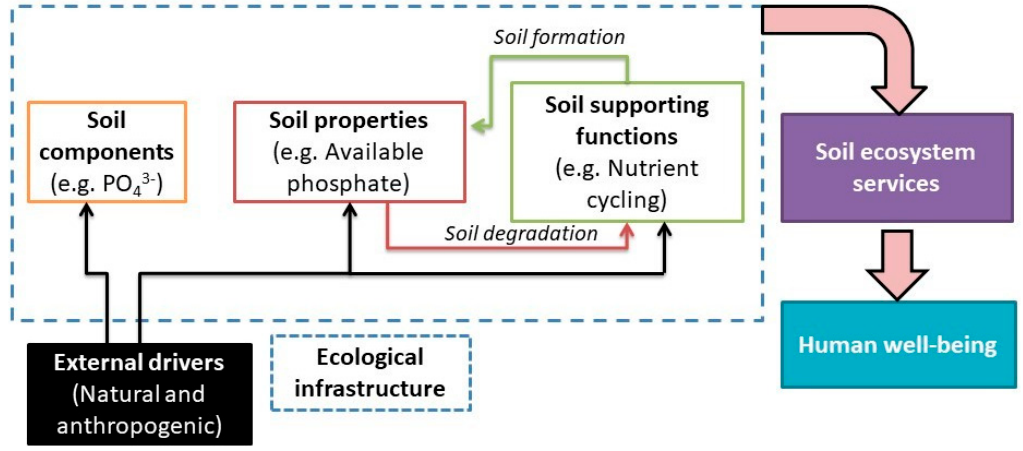
Figure 1. Framework for the provision of ecosystem services from soil natural capital. Adapted from [11] and [14].